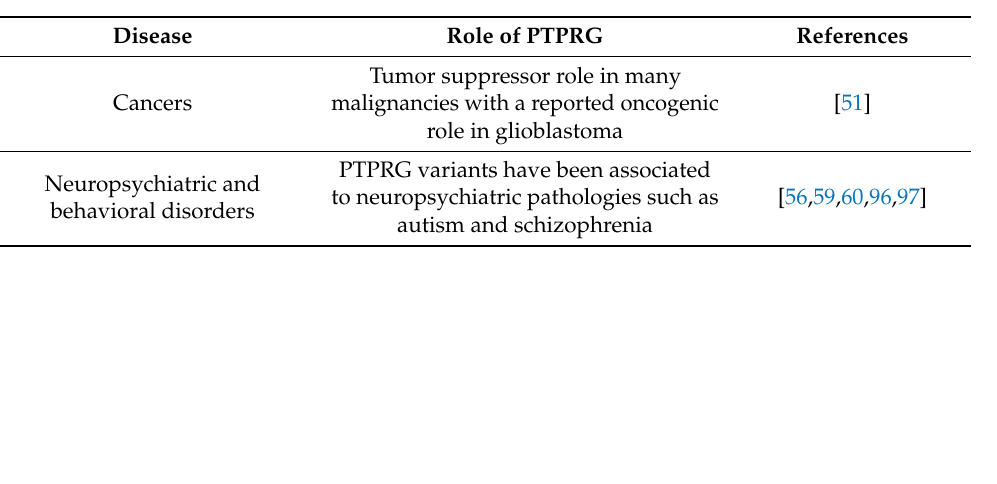
Table 1. Summary table of the pathological processes where PTPRG is